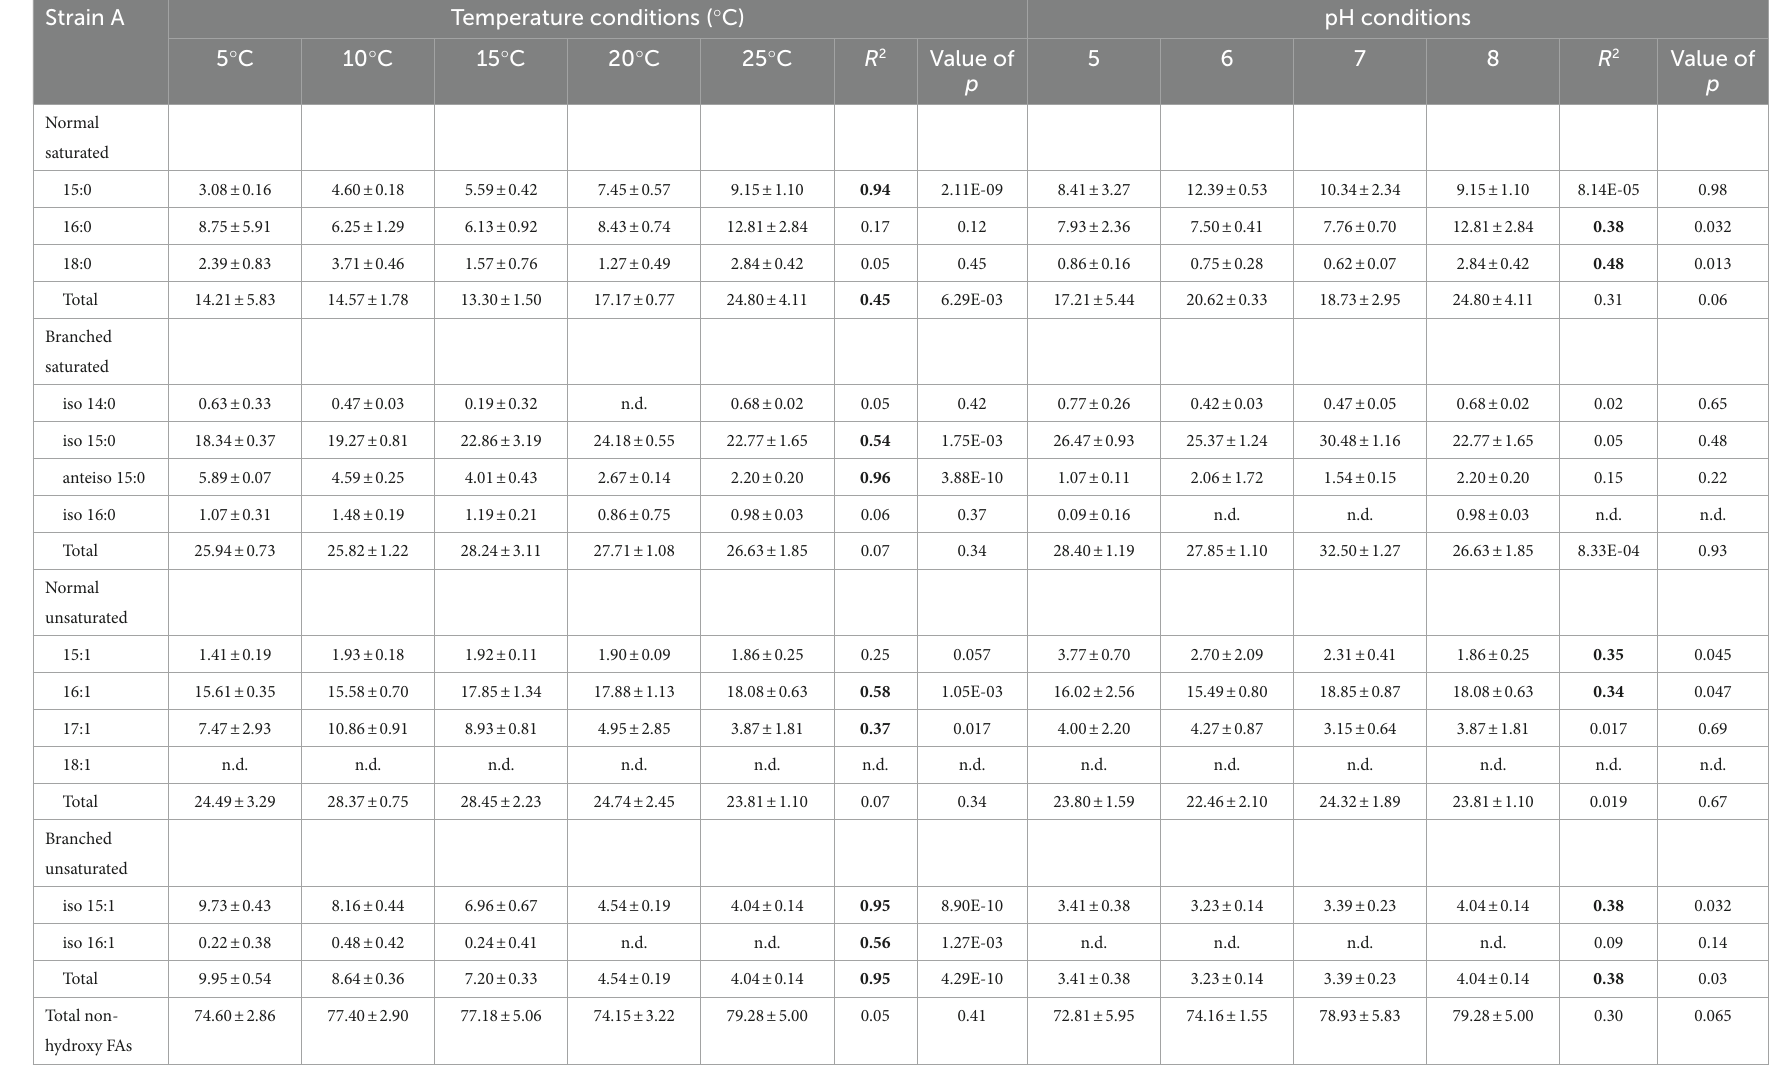
TABLE 1 Relative percentage abundances of non-hydroxy fatty acids vs. total fatty acids for strain A under different temperature conditions (at pH 8) and at different pH conditions (at 25 ° C). Strain